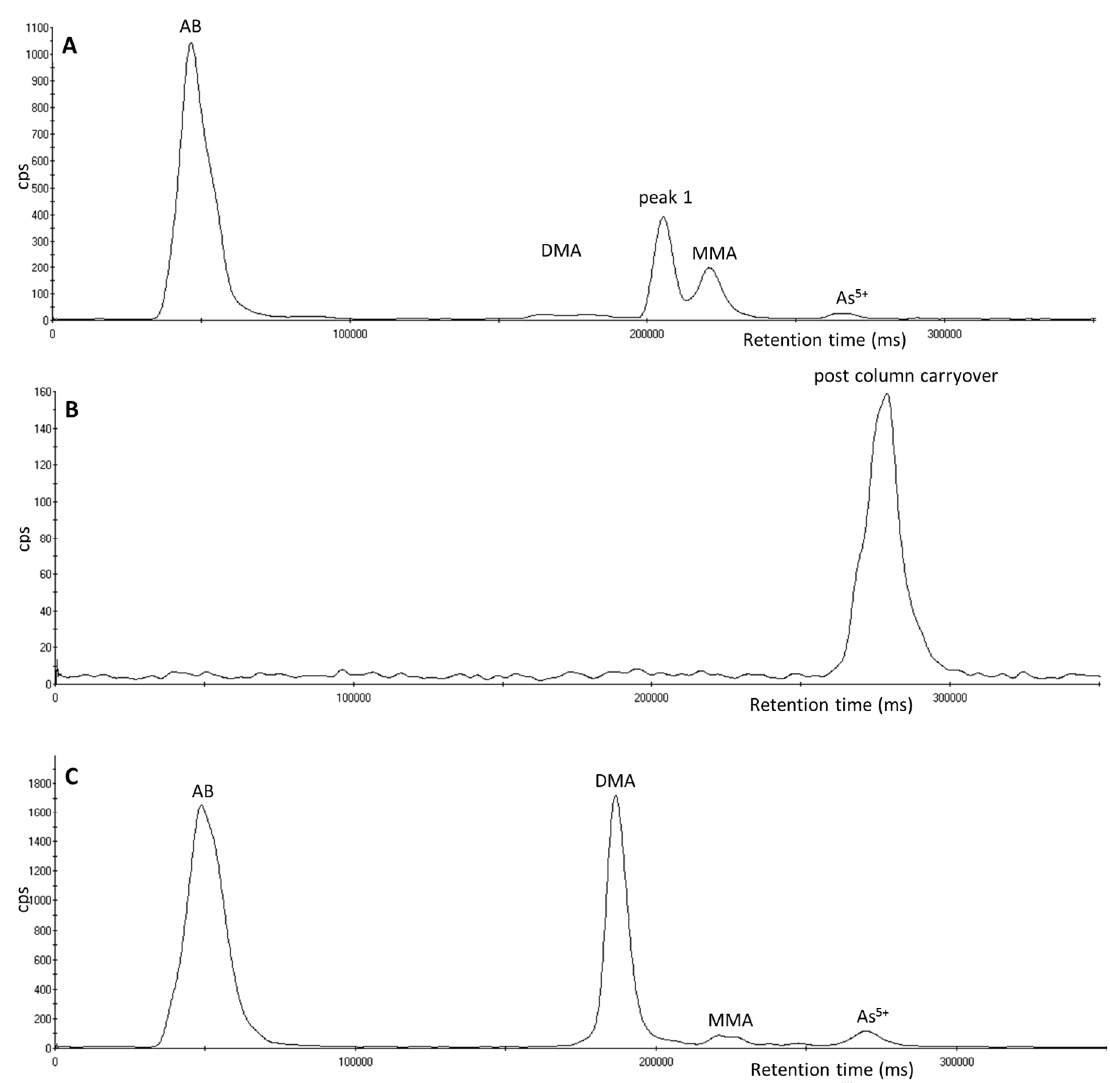
Figure 3. Chromatograms of arsenic species using an ESI OneFAST system coupled to a Dionex AG7 anion exchange column and ICP ‐ MS using mobile phases 2 mM and 70 mM ammonium carbonate solution. ( A ) A urine sample from a hospital patient containing peak 1. ( B ) The post column carryover peak of an unknown into the blank sample immediately after the urine sample containing peak 1. ( C ) Chromatogram of the 5 ‐ day ‐ old urine sample with 100% H 2 O 2 added.